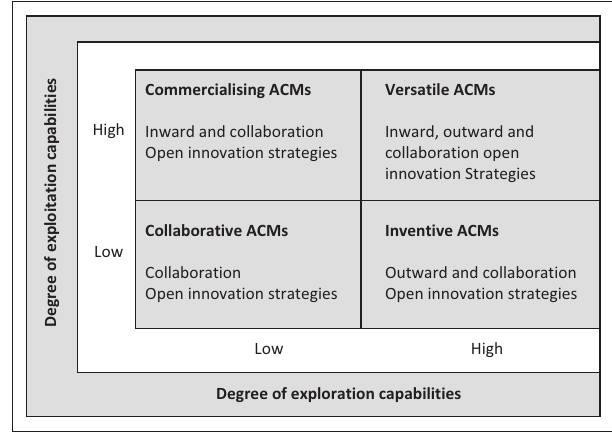
FIGURE 2: Automotive supply chain management open innovation